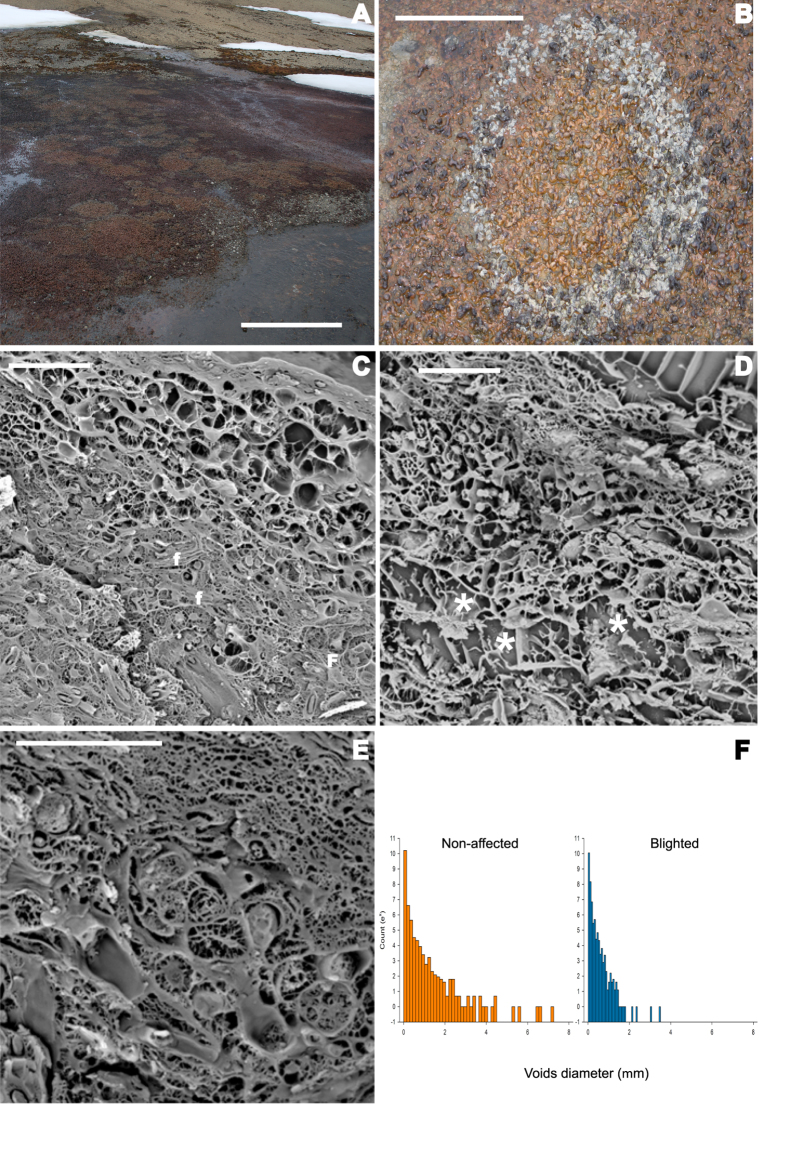
Structural differentiation.(A) General view of a microbial mat harbouring several blighted patches. Scale bar, 100 cm. (B) Macroscopic features of the blighted patches. Scale bar, 40 cm. (C–E) Low Temperature Scanning Electronic Microscopy images of microbial mats from Byers Peninsula. (C) Matrix of a microbial mat from blighted patches. f indicates putative fungal mycelia within the mat. Scale bar, 20 μm. (D) Matrix of a microbial mat from non-affected areas. Asterisks indicate voids with pore diameter greater than 5 μm. Scale bar, 20 μm. (E) Fungal mycelia growing in the voids present in blighted microbial mats. Scale bar, 10 μm. (F) Histogram representing the pore diameters from non-affected (n = 28,635; 50 bins) and blighted (n = 28,635; 50 bins) samples. Both histograms were generated by analysing images obtained through LTSEM.